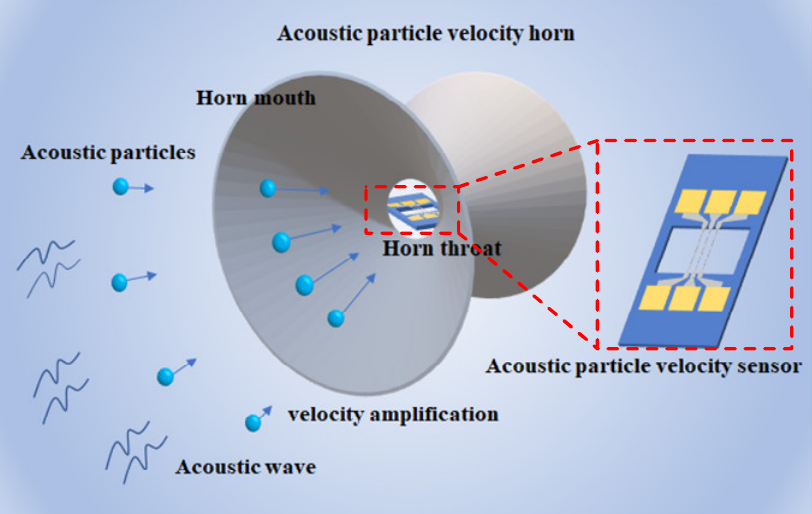
Figure 1. The diagram of a TAPVS packaged in an acoustic horn.